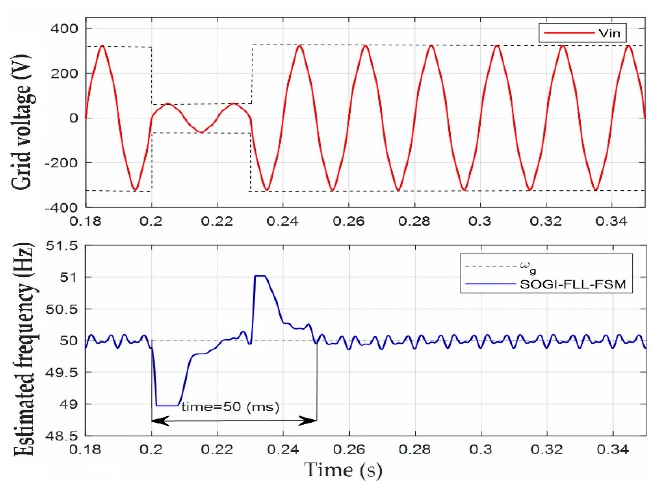
Figure 19. Response of the SOGI-FLL-FSM to a two-cycle 0.2 pu voltage sag at 0.2 s in the presence of a 5th harmonic with 4% amplitude in the grid voltage.